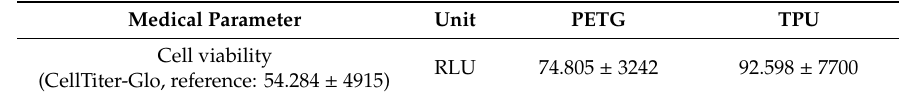
Table 2. Medical characteristics